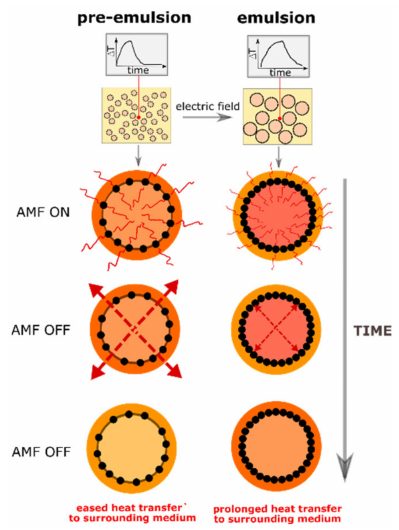
Figure 2. A schematic illustration of the idea of experiments. Di ff erent colors relate to di ff erent temperatures within the magnetic particle shell and outside this. When the alternating magnetic field (AMF) is on, the red lines represent heat generated by particle excitation both toward inside and outside the droplet. When the AMF is switched o ff , the red arrows represent heat transfer from the particle shell to the surrounding medium. For a solid particle shell, the heat transfer might be retarded, and in the emulsion the higher temperature is maintained